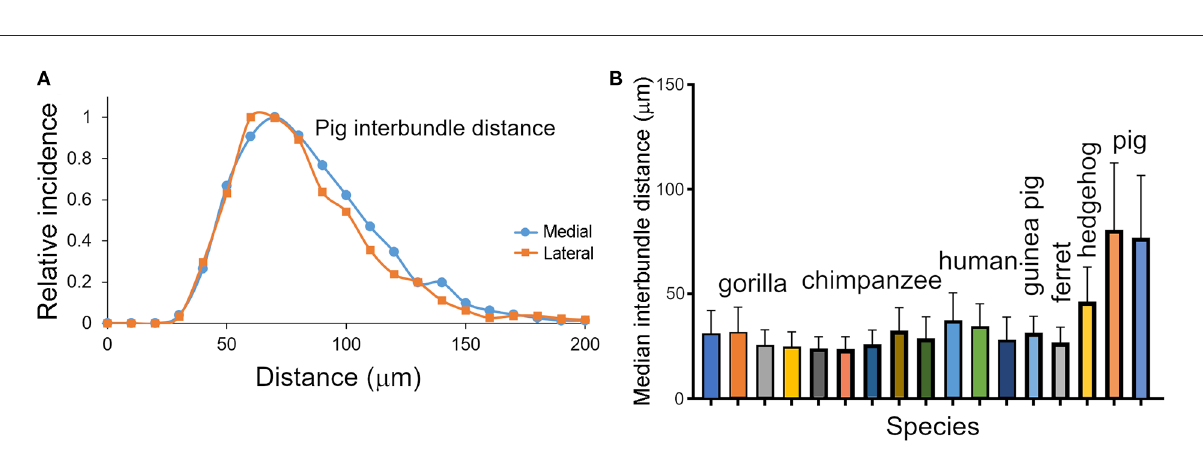
FIGURE4 (A) Distribution of inter-bundle distances measured in orthogonal sections from two blocks of the pig brain. The distribution is flatter than the other species studied and has a different scale on the “X” axis. (B) Histogram showing the median values (with standard deviation) of the inter-bundle distance for orthogonal blocks from each of the species where counts were made. These are the same blocks as described in Table